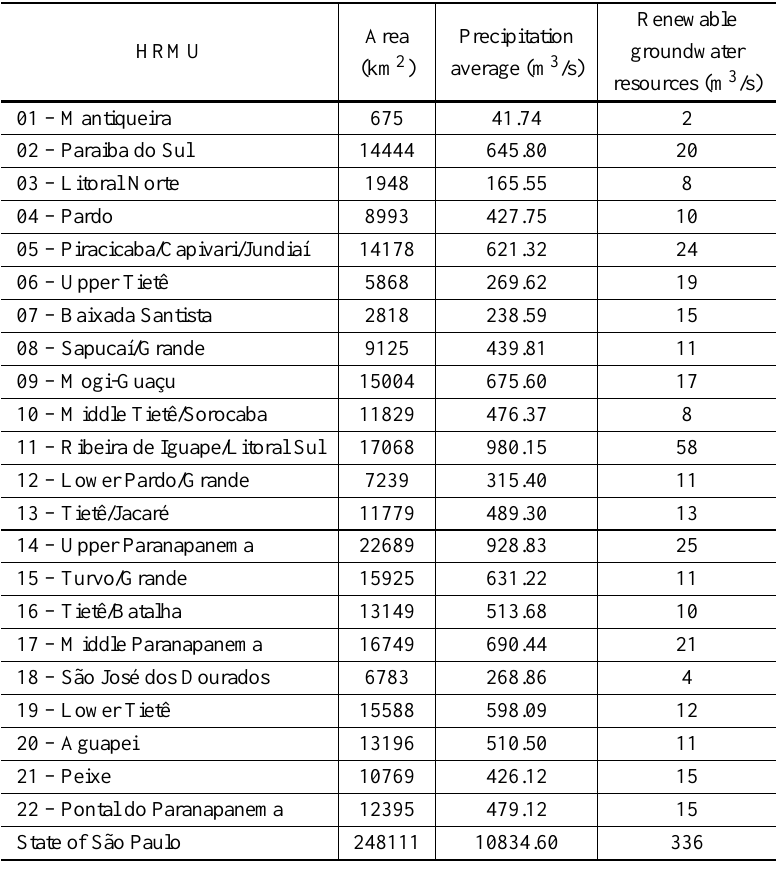
Area, precipitation, renewable groundwater resources for each Water Resource Management Units (WRMU) of the State of São